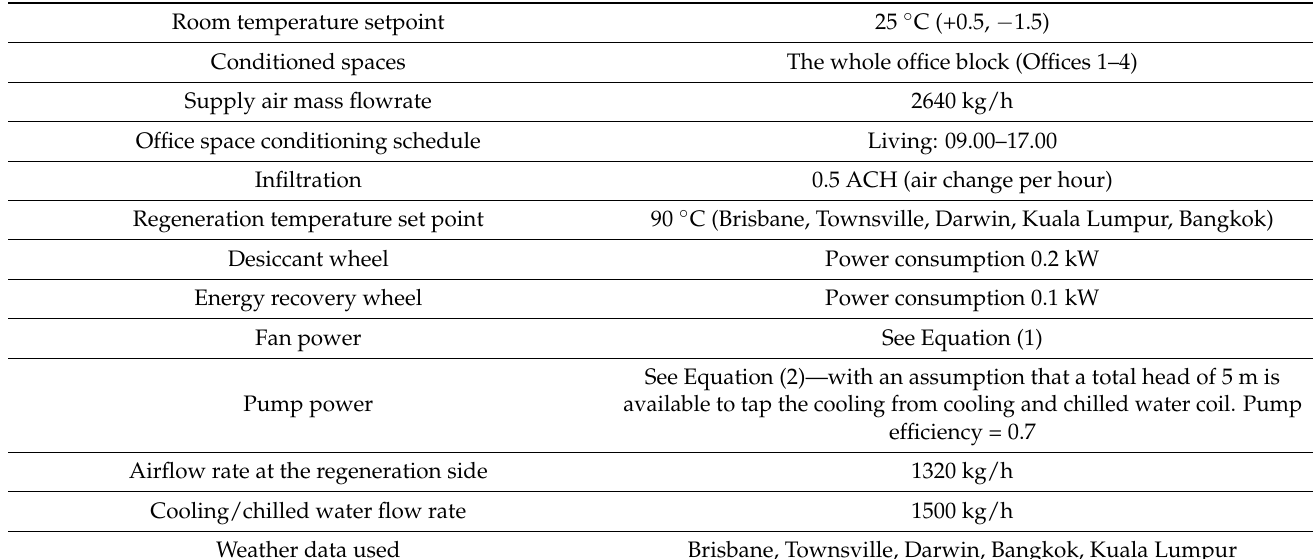
Table 1. Main inputs to the TRNSYS